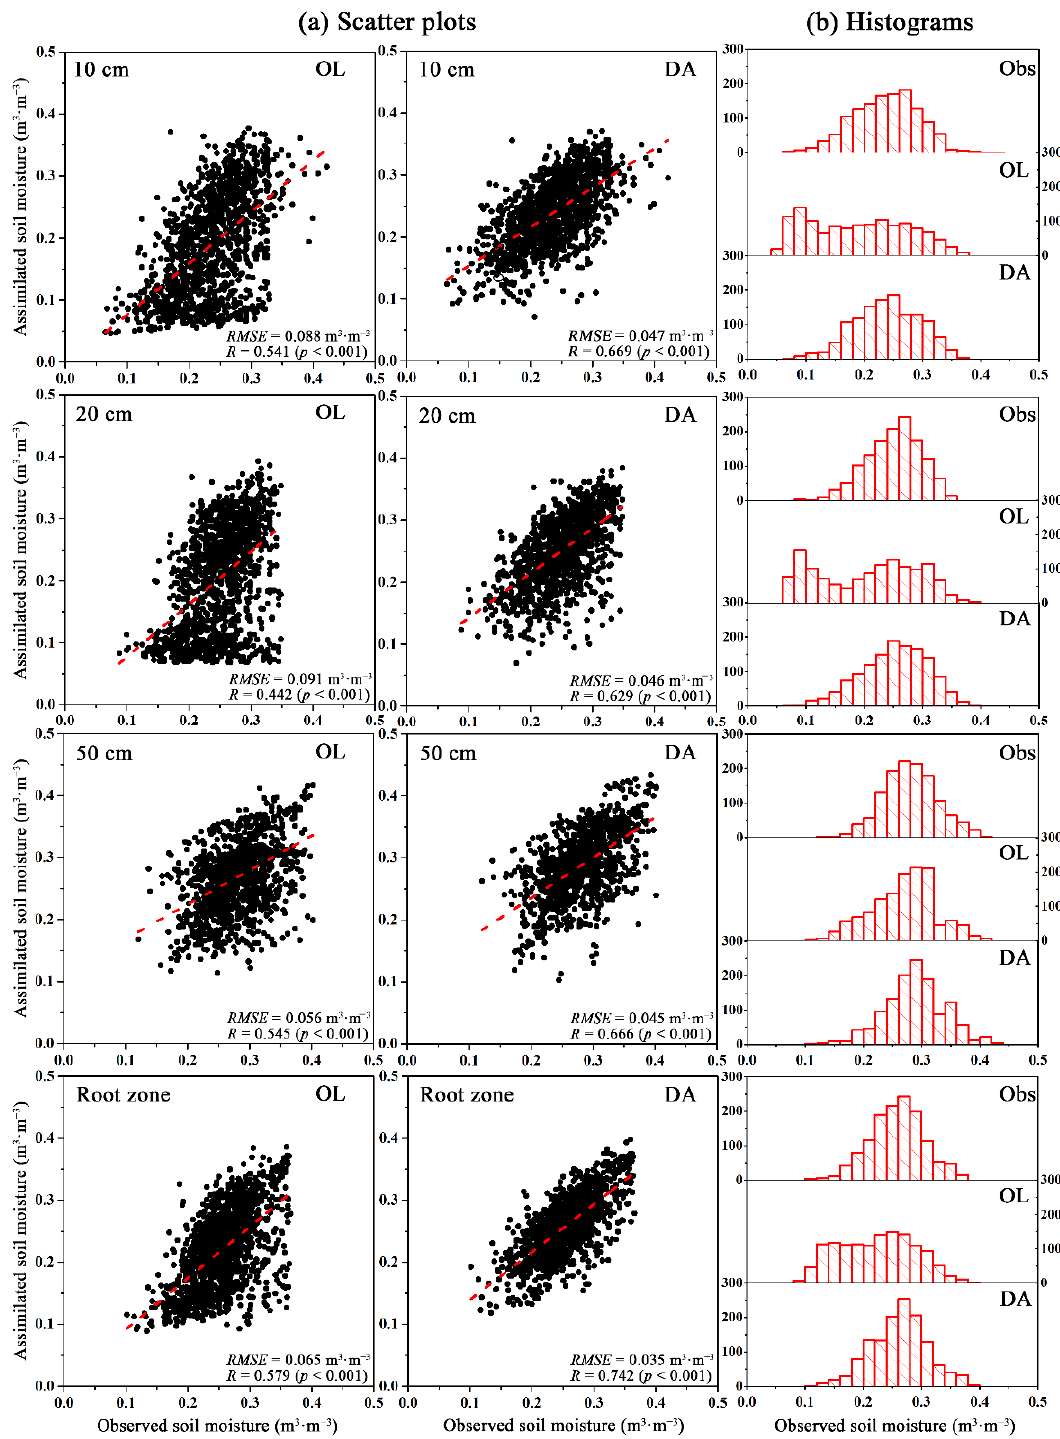
Figure 3. Comparisons of open-loop (OL) and assimilated (DA) soil moisture with observations (Obs)